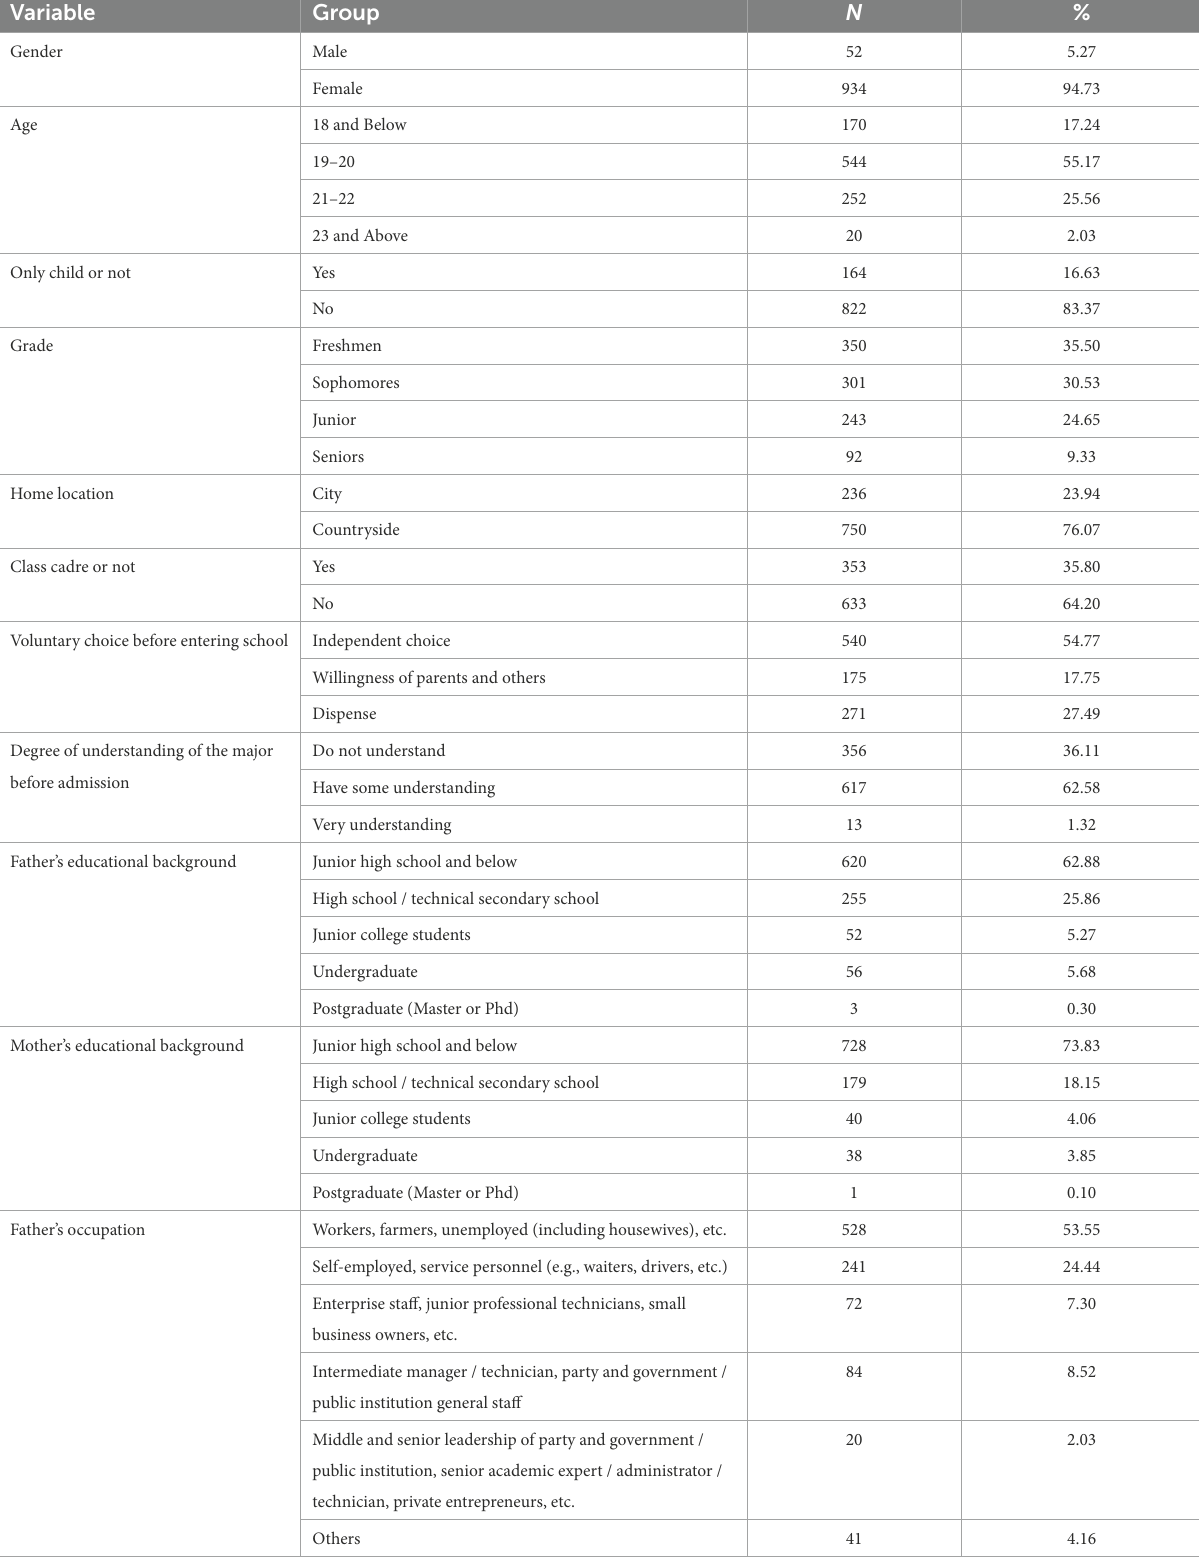
TABLE 1 Demographics of participants ( N =